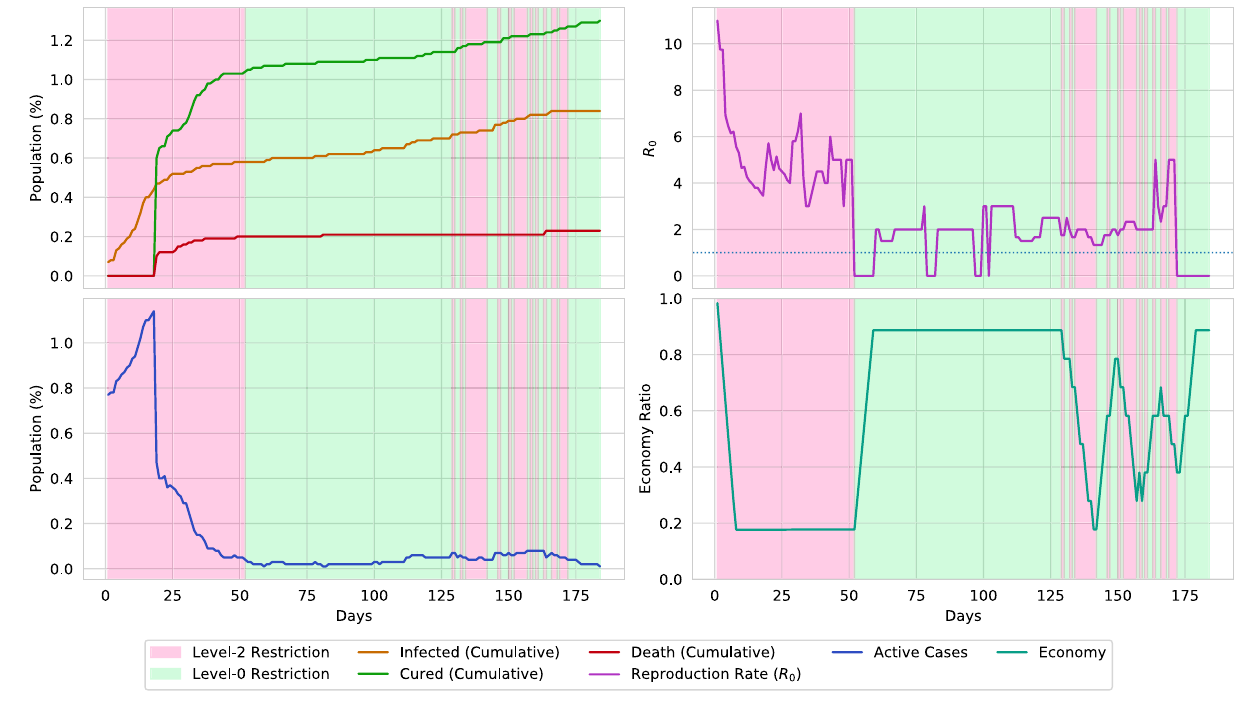
Figure 20. This graph illustrates the actions performed by the agent in a 0.01 population density environment. The other environmental parameters are kept unchanged. The graph resembles a similar action pattern of the agent observed in a 0.02 population density environment. However, less population is infected due to the lesser spread of the disease.